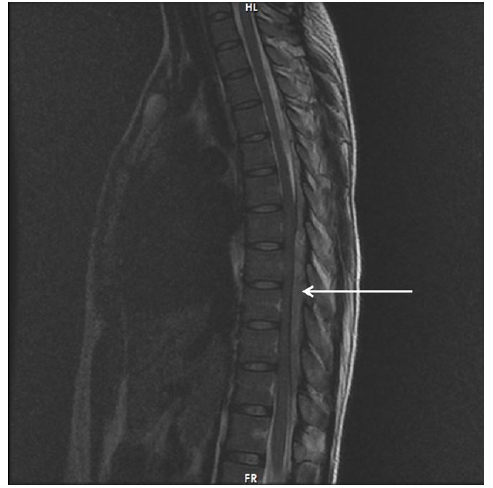
Figure 1. T2-weighted image showing posterior epidural collection from T4 to T10 vertebral level.